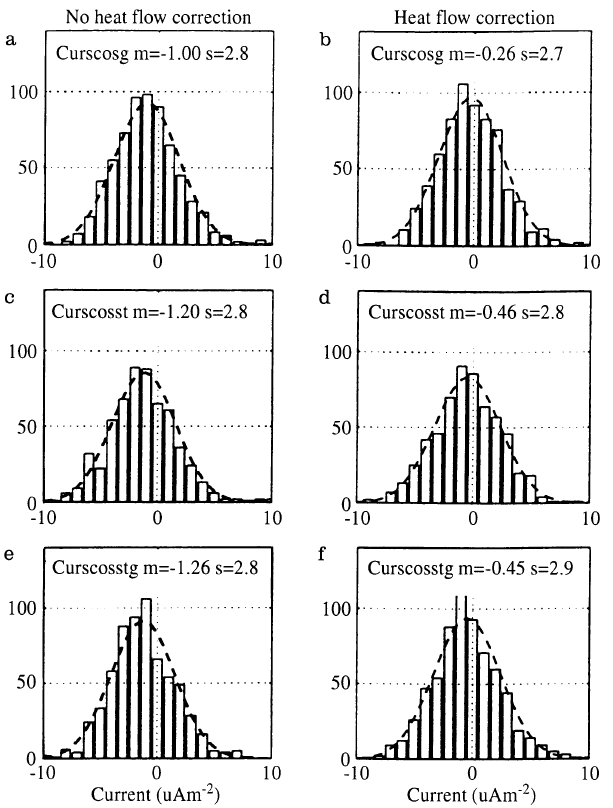
Fig. 10a (cid:177) f. Histogram of the calculated currents without ( left panels ) and with heat-flow correction ( right panels ). The total popu- lation of each histogram is & 700. The dashed lines represent the best fit to a normal distribution. a and b are for the Gaussian model, c and d are for the squared-triangle model, and e and f are for a data analysis taking the parameters of the fit giving the smallest residuals of the squared-triangle and Gausian fits. Note that positive currents are upward currents